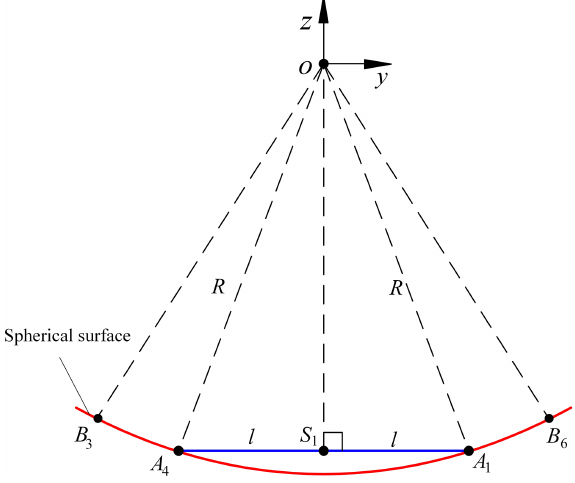
Figure 9. Projection of circle 1 in the yoz plane. rib units are not equal. The basic dimensions of the rib units of each module are the same; that is, each module can be simplified as an envelope circle with an equal radius (Tian et al., 2021), a sphere with radius R can be constructed with several envelope circles with the same radius, a rectangular coordinate system can be established with the center O of the sphere as the coordinate origin, and a coordinate system { O } can be established according to the right-hand rule. The top view of the envelope circle with equal radius is shown in Fig. 8. Envelope circle 1 located in the center is defined as the first envelope circle, and the second envelope circle and the third envelope circle can be regarded as being envelope circles 2 and 8, respectively, which are rotated by 60 ◦ around the z axis, and the centers of the envelope circles 3 and 8 are located on the included angle plane equal to 30 ◦ .